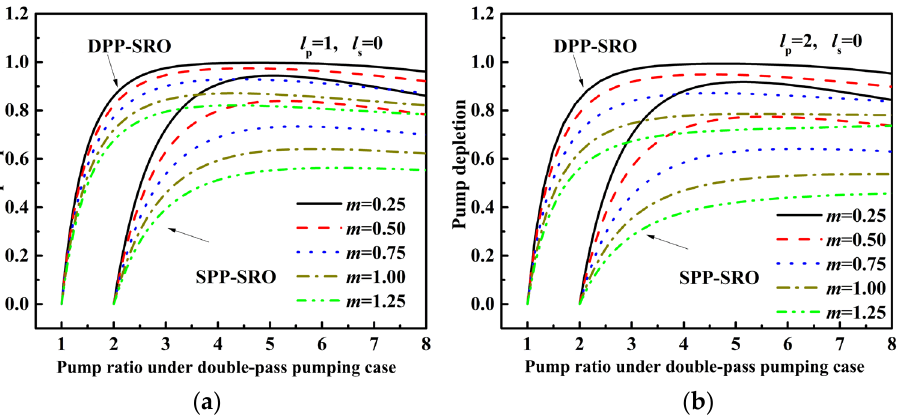
Figure 2. Pump depletion of SROs versus pump ratio under different m. l s = 0 and l p = 1 ( a ); and l p =2 ( b ).